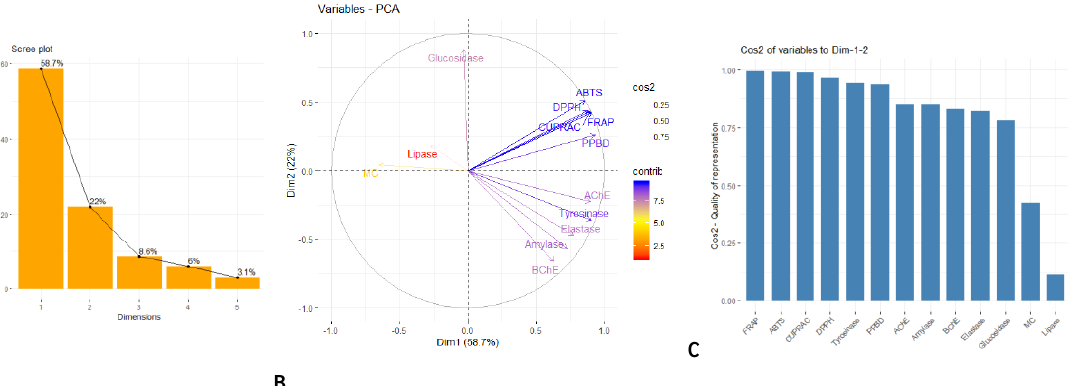
Figure 3. ( A ) Scree plot of percentage of explained variances; ( B ) correlation circle plot; ( C ) bar plot to visualize the quality of representation (cos2) on the correlation circle plot using the results of principal component analysis (PCA).